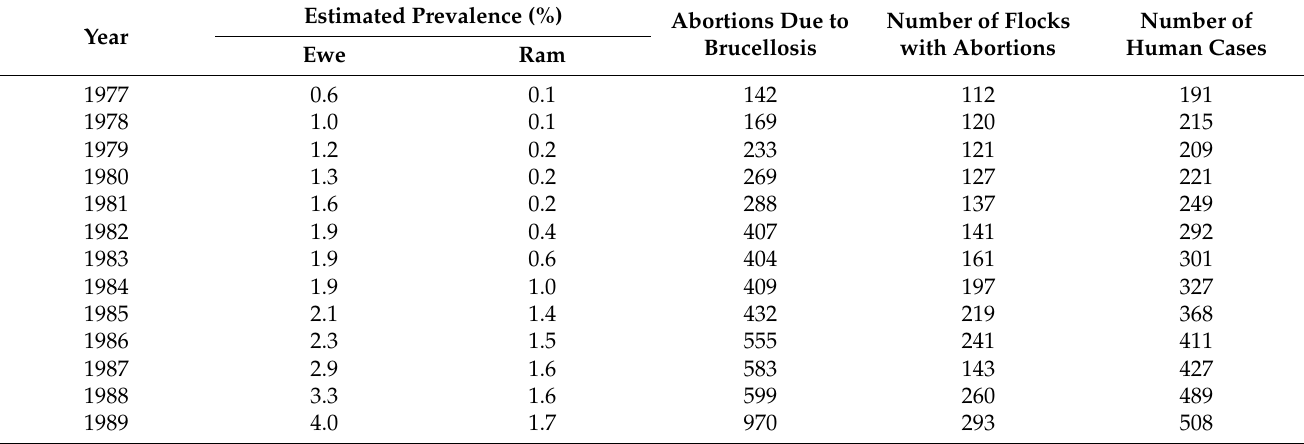
Table 7. Prevalence of brucellosis in small ruminants with B. melitensis Rev1 vaccine in Kyrgyzstan from 1977–1989. Cattle and small ruminants were positive in two consecutive Rose-Bengal plate tests and/or serum agglutination tests. Based on reports from the SIVPS, adapted from Kasymbekov J. (2014)